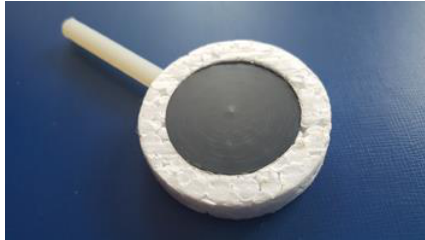
Figure 2. Photo of a polyvinyl chloride (PVC) sample with sample holder.